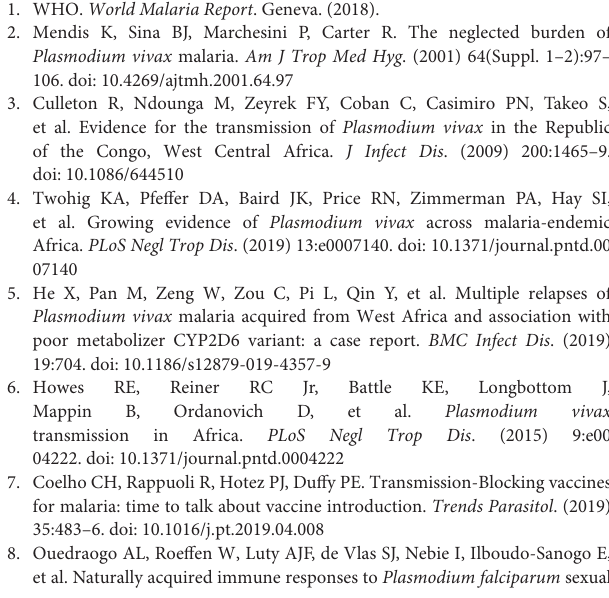
Figure S1 | Correlation between age and antibody titers against PvDBP-RII, PvCSP, and Pfs230D1M in Cambodia. Figure S2 | Confirmation of depletion (or reduction) of Pvs230D1M IgG from sera used to evaluate Pfs230D1M IgG levels. Figure S3 | Specificity of Pvs230D1M IgG depletion. PvDBP-RII IgG levels remain unaltered after depletion of Pvs230D1M